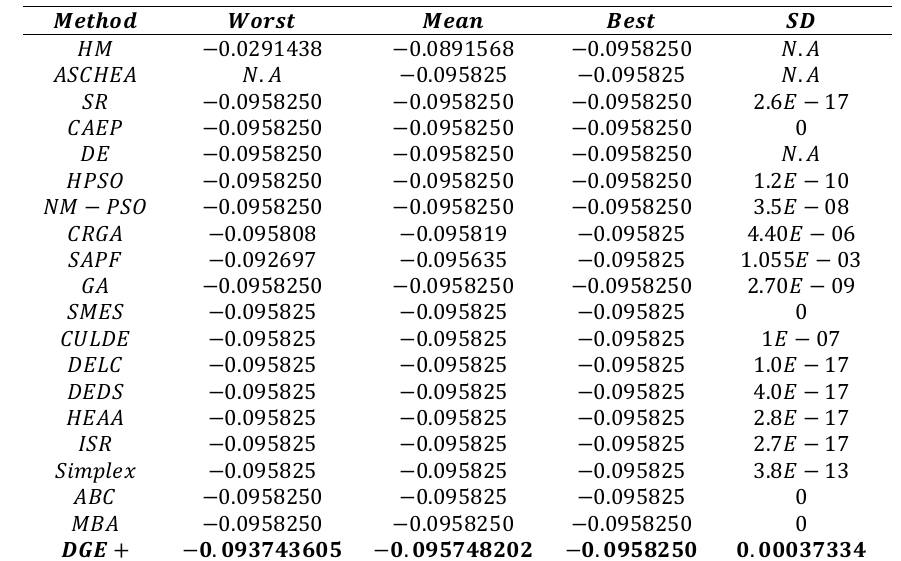
Table 7. Statistical comparison of results for constrained problem 4 of various algorithms